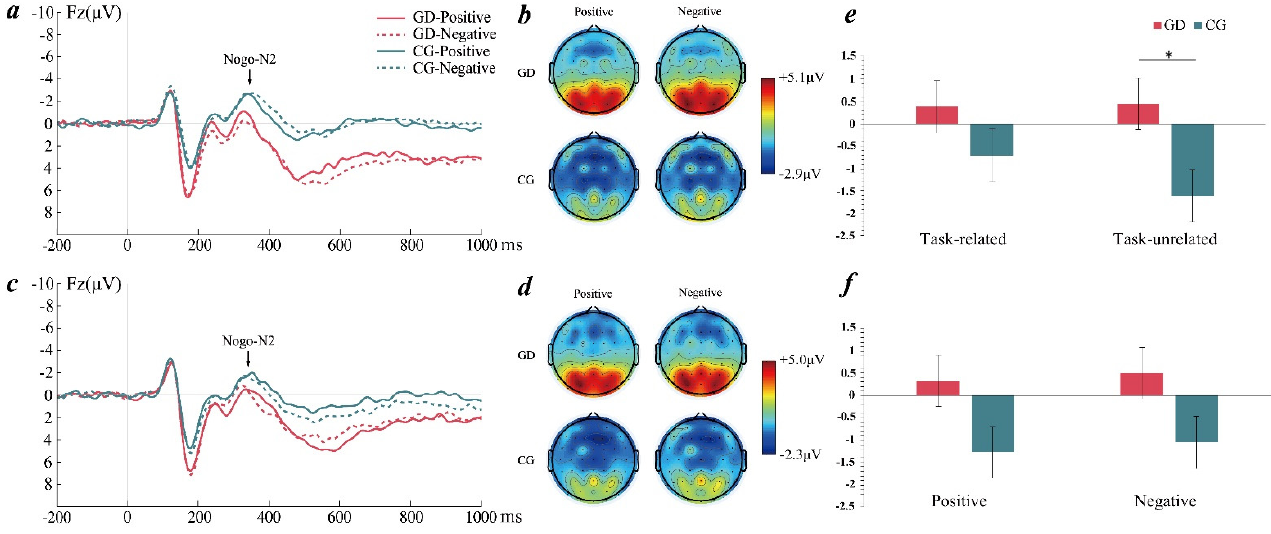
Figure 4. ( a ) Averaged ERPs at Fz for two groups in the task-unrelated condition; ( b ) topographic maps of nogo-N2 for two groups in the task-unrelated condition; ( c ) averaged ERPs at Fz for two groups in the task-related condition; ( d ) topographic maps of nogo-N2 for two groups in the task- related condition. GD = gaming disorder group, CG = control group. ( e ) Task × group interaction on nogo-N2 amplitudes. ( f ) Valence × group interaction on nogo-N2 amplitudes. The error bars stand for the standard deviation of the means. * p < 0.05.